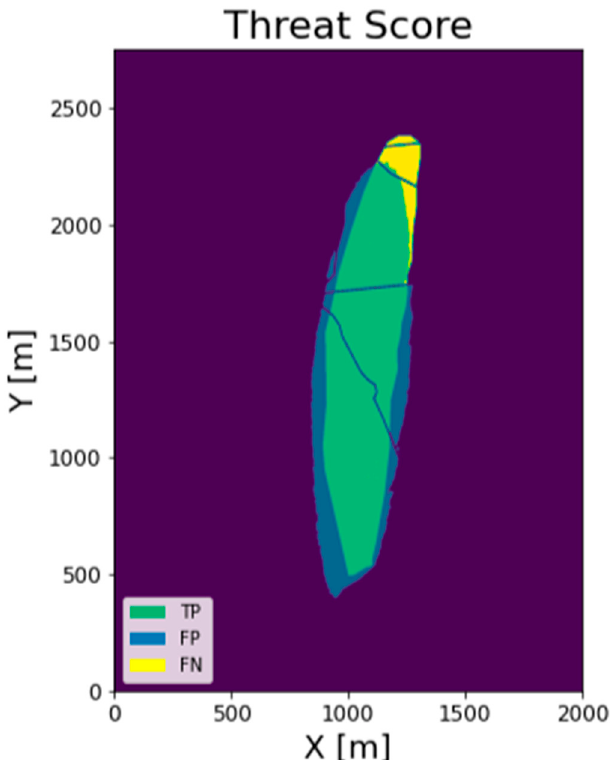
Figure 7. Visualization of threat score analysis comparing the simulated fire footprint to the field estimated burn plot 1 h after initial ignition. The green area represents the true positives, while the blue and yellow regions denote false positive and false negatives.